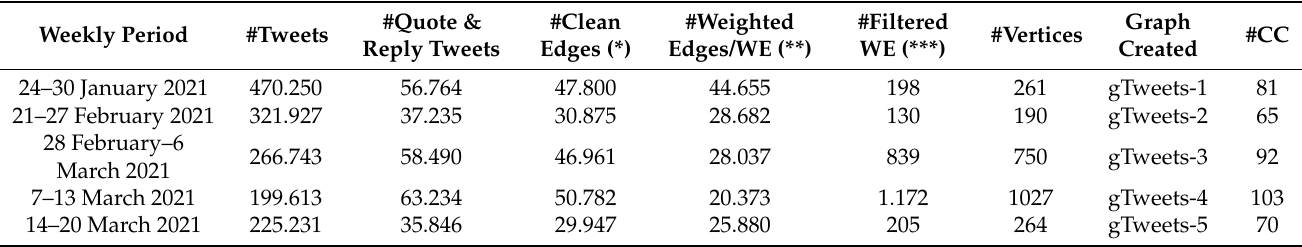
Note of Table 2: CC = connected component. (*) attribute value of src and dst are not null, not self-reply/quote (src = dst). (**) group by distinct pair of src-dst attribute. (***) filtered by thWeight = 3, which means every record of edges representing user interacting (by replying or quoting tweets) at least four times in a